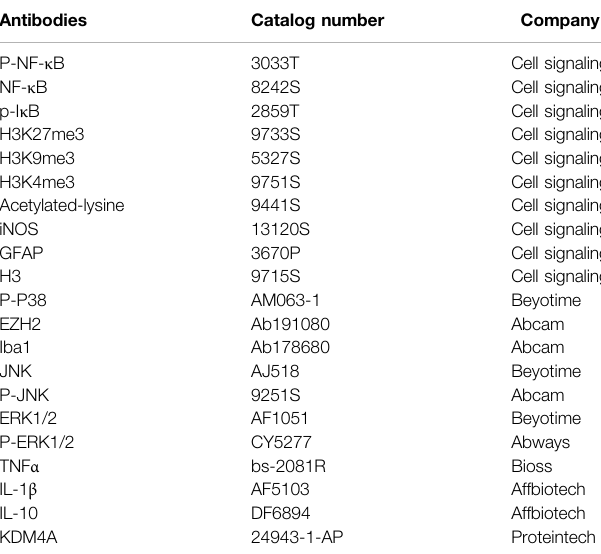
TABLE 1 | Antibodies used for immunohistochemistry, Western blotting, and ChIP. Antibodies Catalog number Company